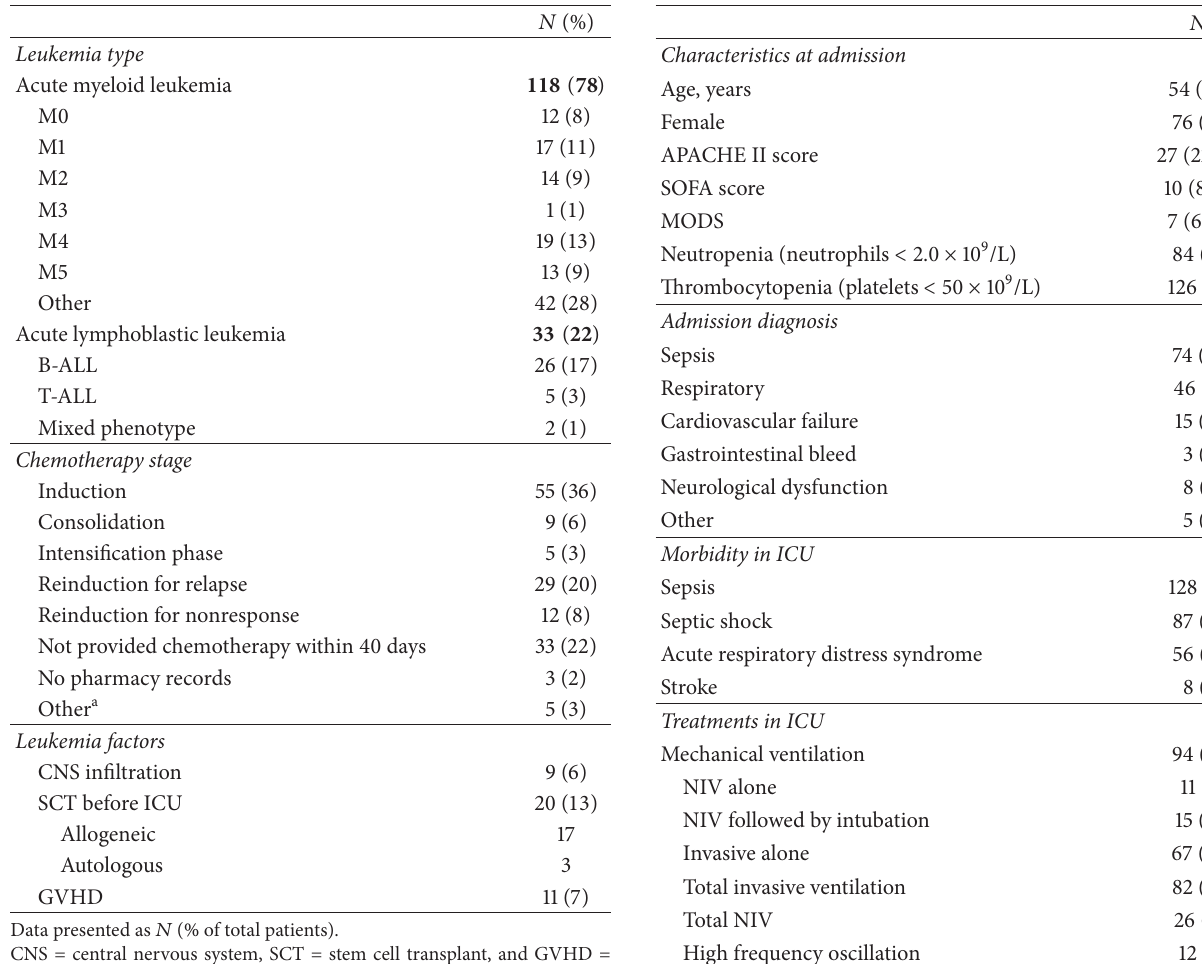
Table 1: Patient leukemia characteristics ( 𝑁 = 151 ). Table 2: Patient characteristics and outcomes ( 𝑁 = 151